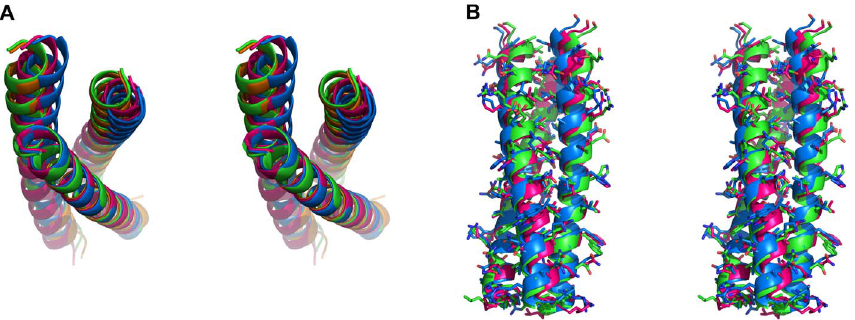
Figure 11. Superposition of the N-HR helices of gp41 in the (Fab) 3 /3-H complexes and in 6-helix bundles based on the C a atoms of a single helix. (A) N-HR helices of the (Fab 8066) 3 /3-H complex (red), of the (Fab 8062) 3 /3-H complex (blue), of the 6-helix bundle of gp41 with a GCN4 zipper [25]: PDB code 1ENV (green), and of the 6-helix bundle of gp41 [24]; PDB code 1AIK (orange). (B) Shifts in the positions of the side chains in the N-HR helices of the 3 Fab 8062/3-Hcomplex (blue) with respect to their counterparts in the (Fab 8066) 3 /3-H complex (red) and 6-helix bundle (1ENV, green) indicates a greater degree of twist around the 3-fold axis of symmetry of the trimer.